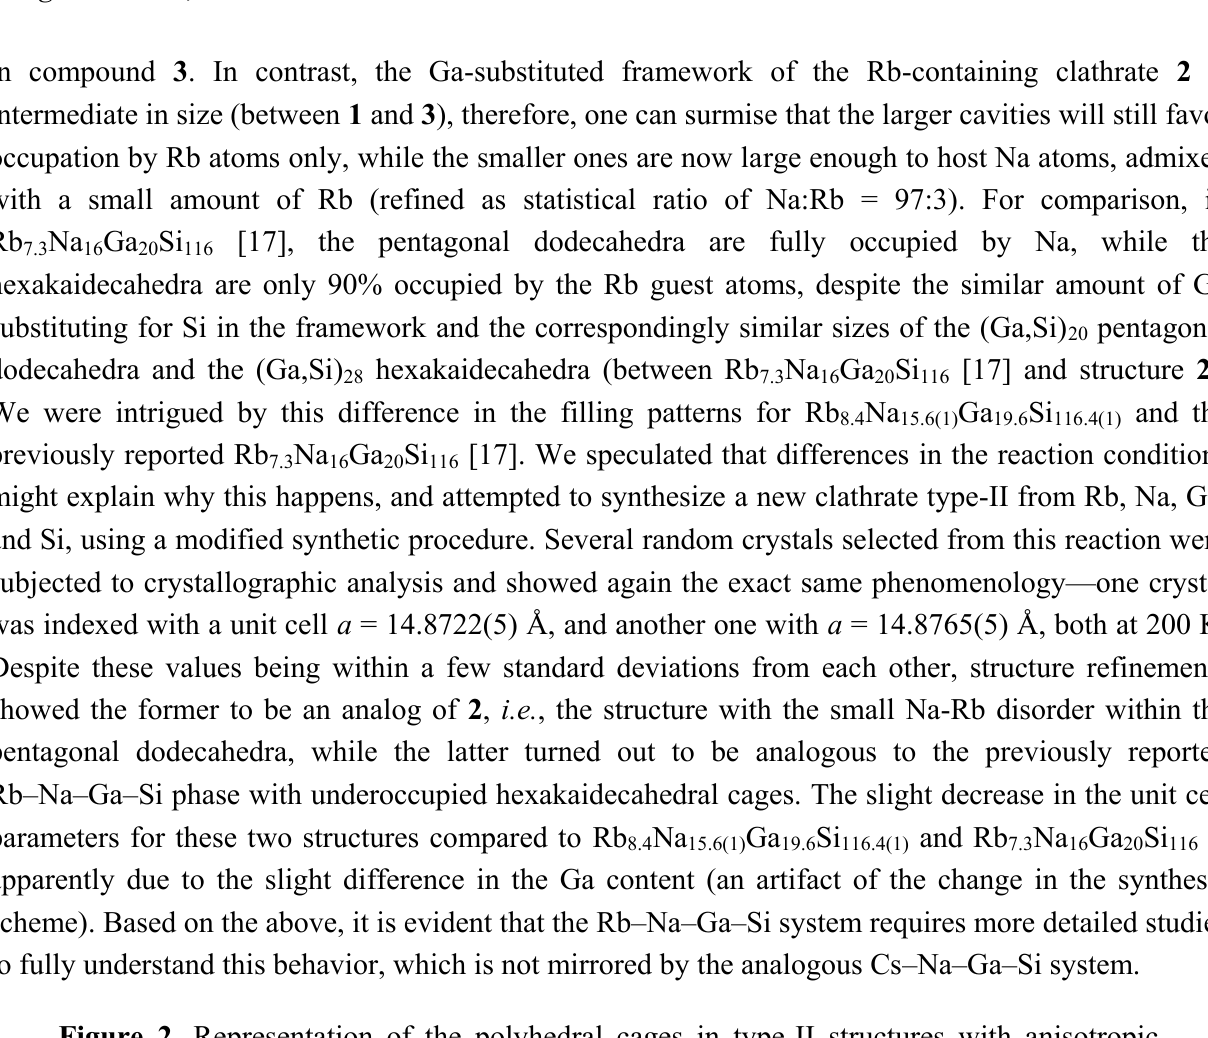
Figure 2. Representation of the polyhedral cages in type-II structures with anisotropic displacement parameters, drawn at the 95% probability level. Cs